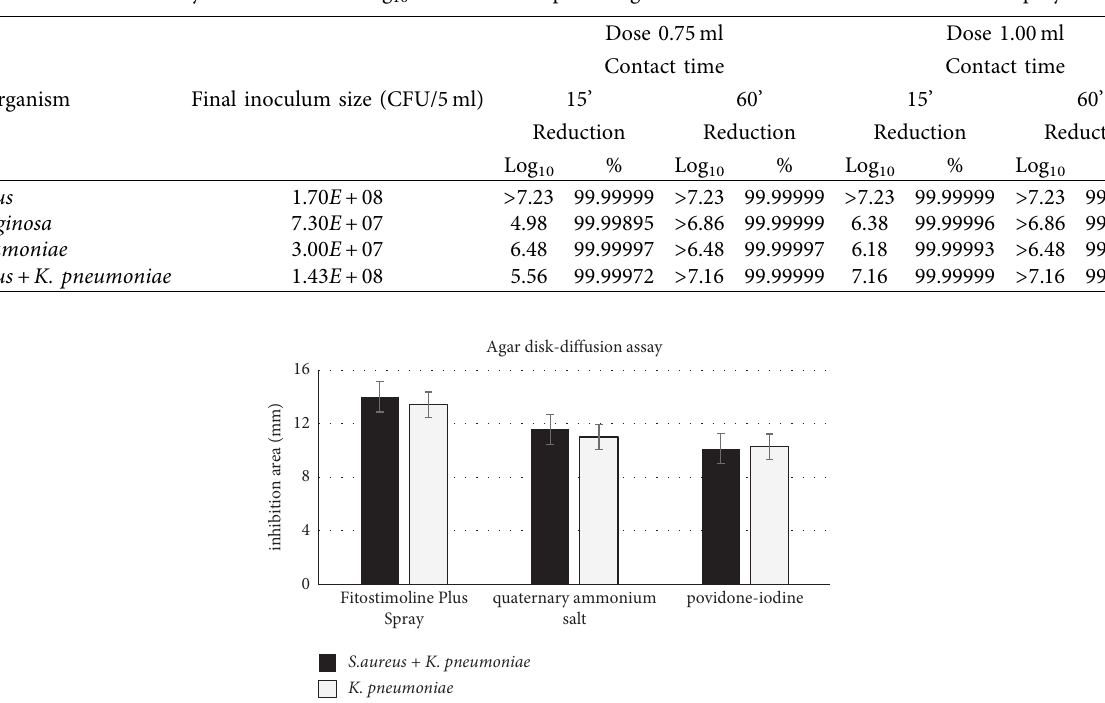
10 reduction and percentage after the action of Fitostimoline